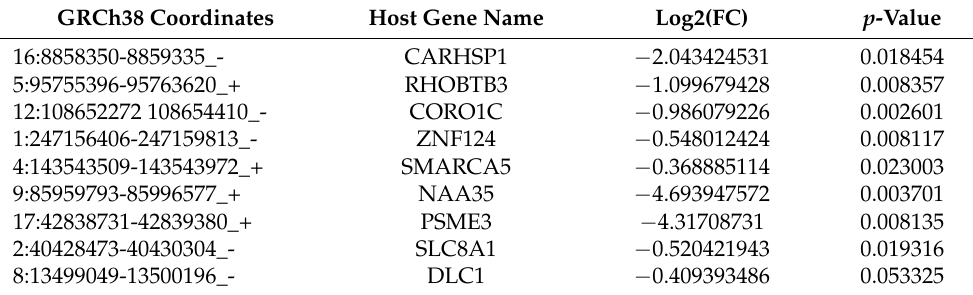
Table 1. List of circRNAs analyzed in this